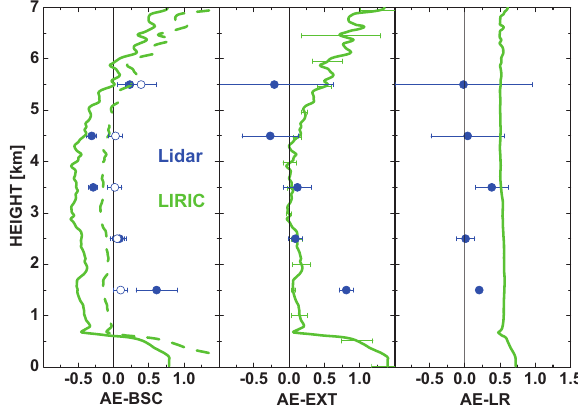
Fig. 7. Backscatter-related ˚Angstr¨om exponent (AE-BSC), Fig. 7. Backscatter–related ˚Angstr¨om exponent (AE-BSC), extinction-related ˚Angstr¨om exponent (AE-EXT), and lidar-ratio- extinction–related ˚Angstr¨om exponent (AE-EXT), and lidar–ratio– related ˚ Angstr¨om exponent (AE-LR) observed on 29 May 2008 related ˚ Angstr¨om exponent (AE-LR) observed on 29 May 2008 with Raman lidar (blue circles) and derived by using the LIRIC with Raman lidar (blue circles) and derived by using the LIRIC pro- profiles in Fig. 3 (green curves). Solid green curve and closed files in Figure 3 (green curves). Solid green curve and closed blue blue symbols show the ˚Angstr¨om exponents for the 355–532nm symbols show the ˚Angstr¨om exponents for the 355–532 nm wave- wavelength range; dashed green curve and open blue symbols for length range, dashed green curve and open blue symbols for the the 532–1064nm spectral range. As outlined by Ansmann et al. 532–1064 nm spectral range. As outlined by Ansmann et al. (2002), (2002), AE-EXT=AE-BSC+AE-LR. Raman lidar signals are AE-EXT = AE-BSC + AE-LR. Raman lidar signals are smoothed smoothed with window lengths of about 1000m in the case of with window lengths of about 1000 m in the case of extinction co- extinction coefficients and the lidar ratio, and 60m in the case of efficients and the lidar ratio, and 60 m in the case of the backscatter the backscatter coefficients. Errors bars indicate the uncertainties coefficients. Errors bars indicate the uncertainties (one standard de- (one standard deviation). LIRIC error bars are given for AE-EXT viation). LIRIC error bars are given for AE-EXT only. only.